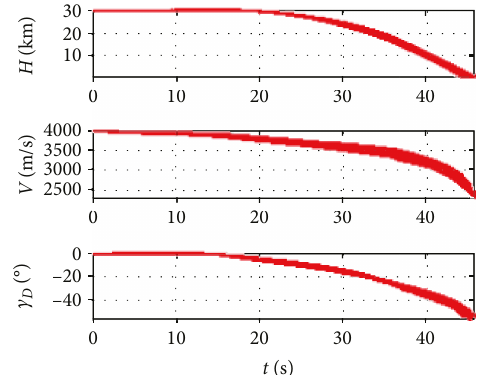
Figure 18: Curves representing the height, velocity, and terminal